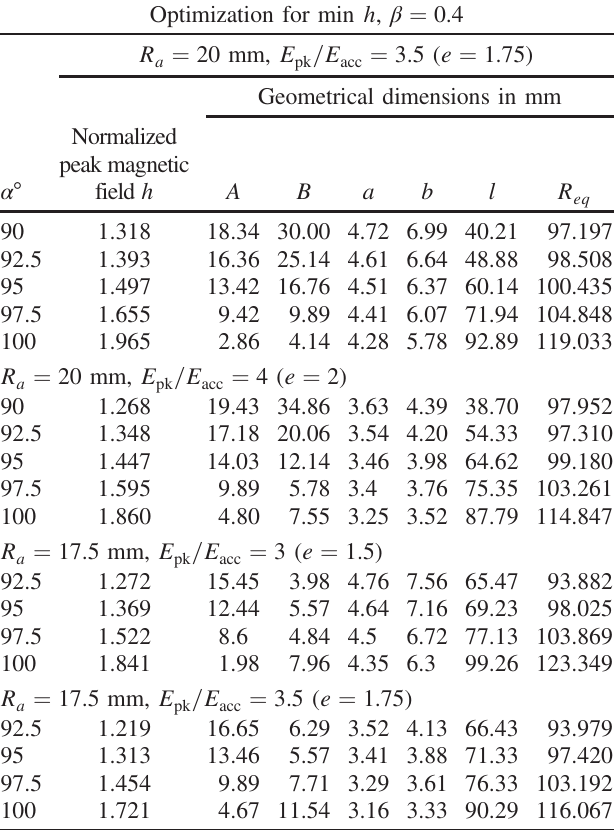
=E = 42 , and dimensions of pk acc =E (or min h ) and pk acc